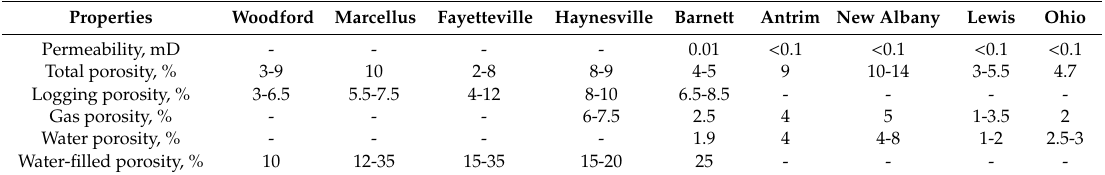
Table 2. Statistical physical properties of the main shale gas reservoirs in North America [3,15,18,19,25,26].